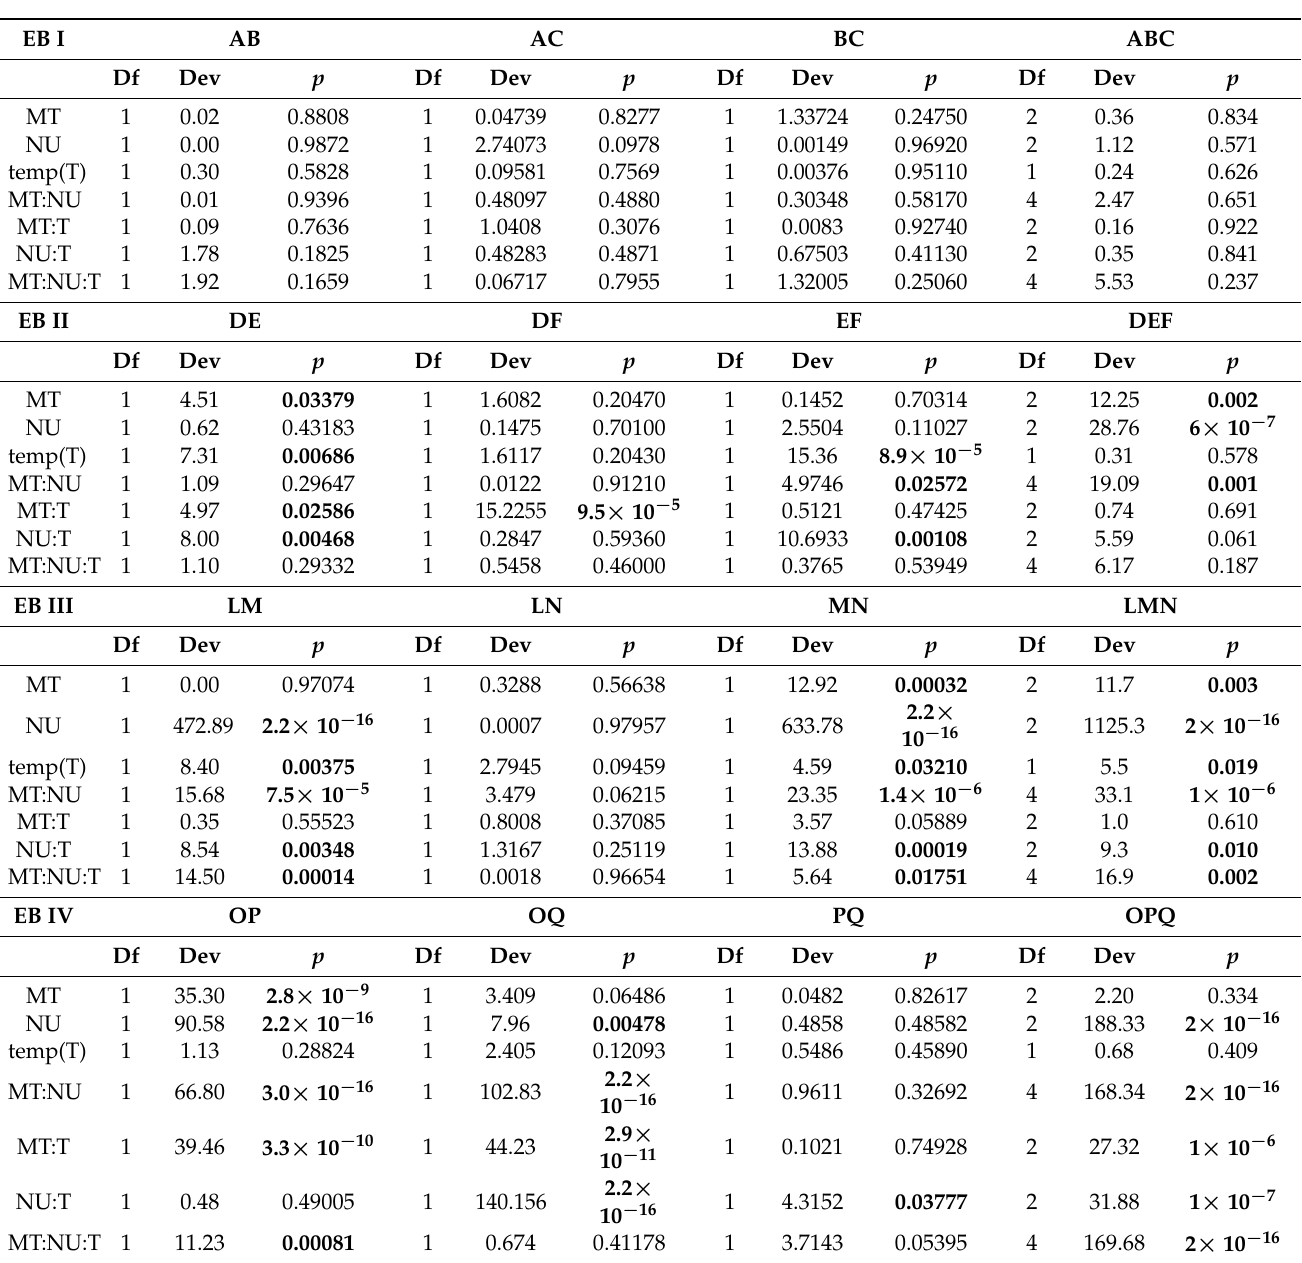
Table 11. The effect of mitochondrial haplotype (MT), nuclear genetic background (NU), tempera- ture (T) and their interactions on the percentage of males for three pairwise comparisons and the experimental block (EB) analysed as a whole for each of the four experimental blocks. DF, degrees of freedom; Dev, deviance; p values that are significant at p < 0.05 are given in